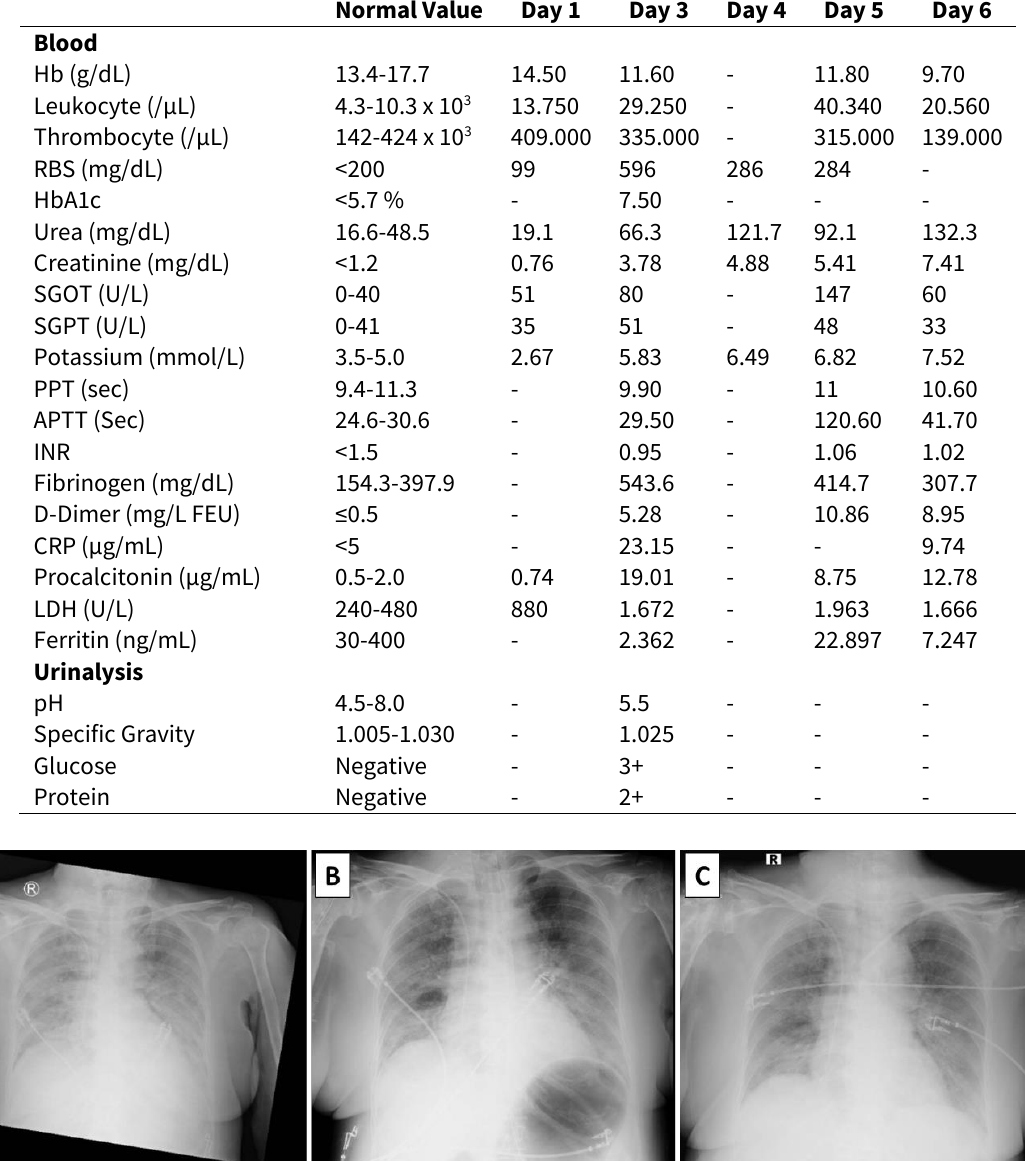
Table 1 . Results of Monitoring Laboratory Examination of Patient 1